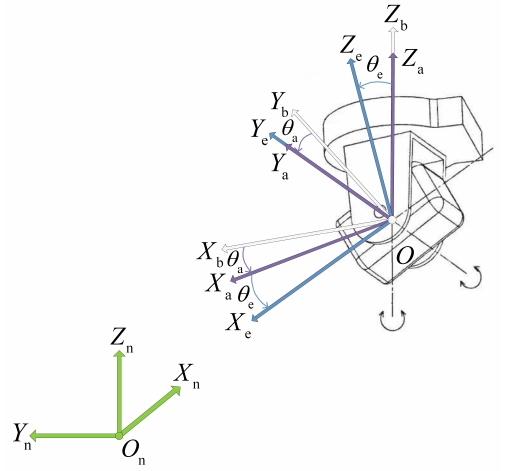
Figure 1. Coordinate systems of the